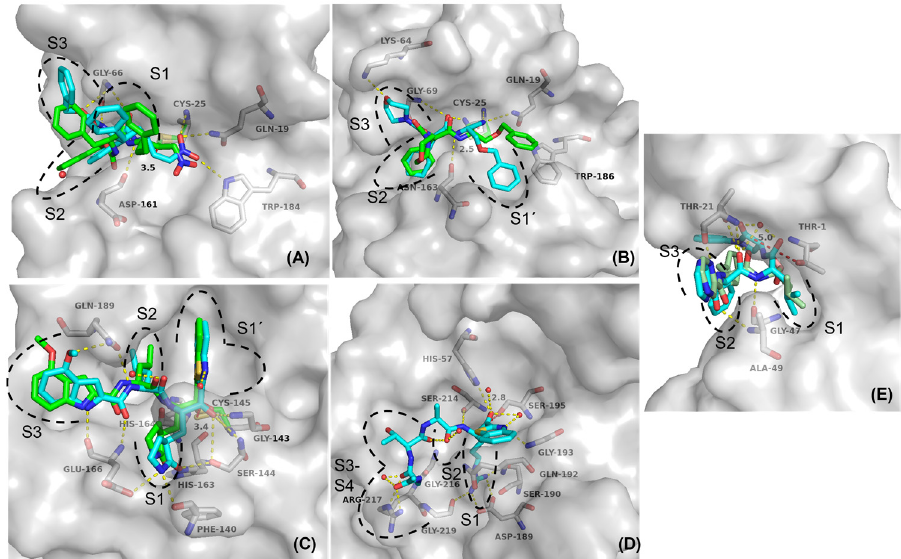
Figure 7. Predicted binding modes and polar interactions (yellow dashed lines) of different inhibitor classes with different enzymes (white carbon atoms and surface). For non-covalent docking poses, the distance between electrophilic carbon and nucleophilic sulfur or oxygen is shown as a red dashed line, with the distance measured in Å. For a clear view, only amino acids that form polar interactions with the ligands are shown as sticks and labelled. Black dashed lines indicate subpocket locations. Non-covalent docking poses are shown with cyan C-atoms and the covalent docking poses with green C-atoms. ( a ) Superposition of the non-covalent and the covalent docking pose of 13 with rhodesain, PDB-ID (2P7U). ( b ) Superposition of the non-covalent and the covalent docking pose of 30 with CatS, PDB-ID (1MS6). ( c ) Superposition of the non-covalent and the covalent docking pose of 90 with SARS-CoV-2-M pro , PDB-ID (6XR3). ( d ) Predicted binding mode of non-covalently docked 103 with uPA, PDB-ID (1W10). ( e ) Superposition of the non-covalent docking pose of 72 and bortezomib (palegreen C-atoms) with the β -5 subunit of human 20S-proteasome, PDB-ID (5LF3). The docking with rhodesain (pdb entry 2P7U) indicated that the introduction of a